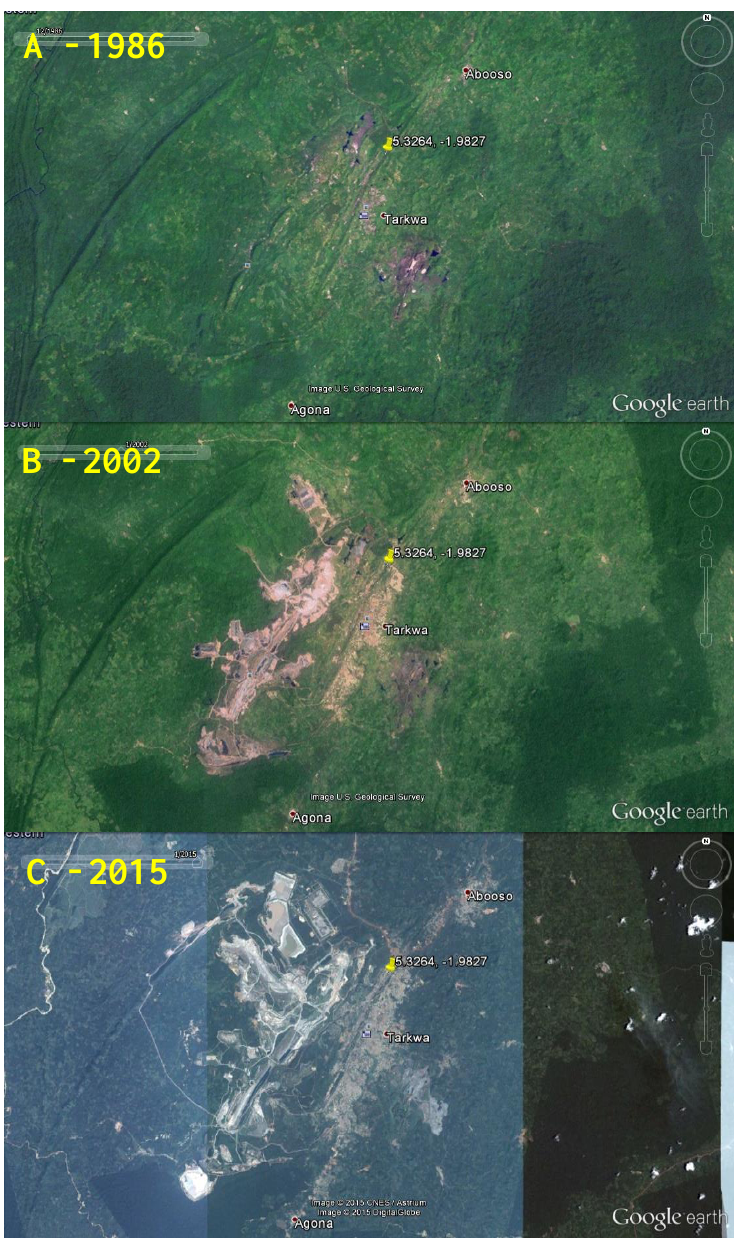
Figure 11. Satellite photos of Tarkwa, Western Region, from December 1986 ( A ), January 2002 ( B ), and January 2015 ( C ), depicting rapid gold mining development. Images from Google Earth